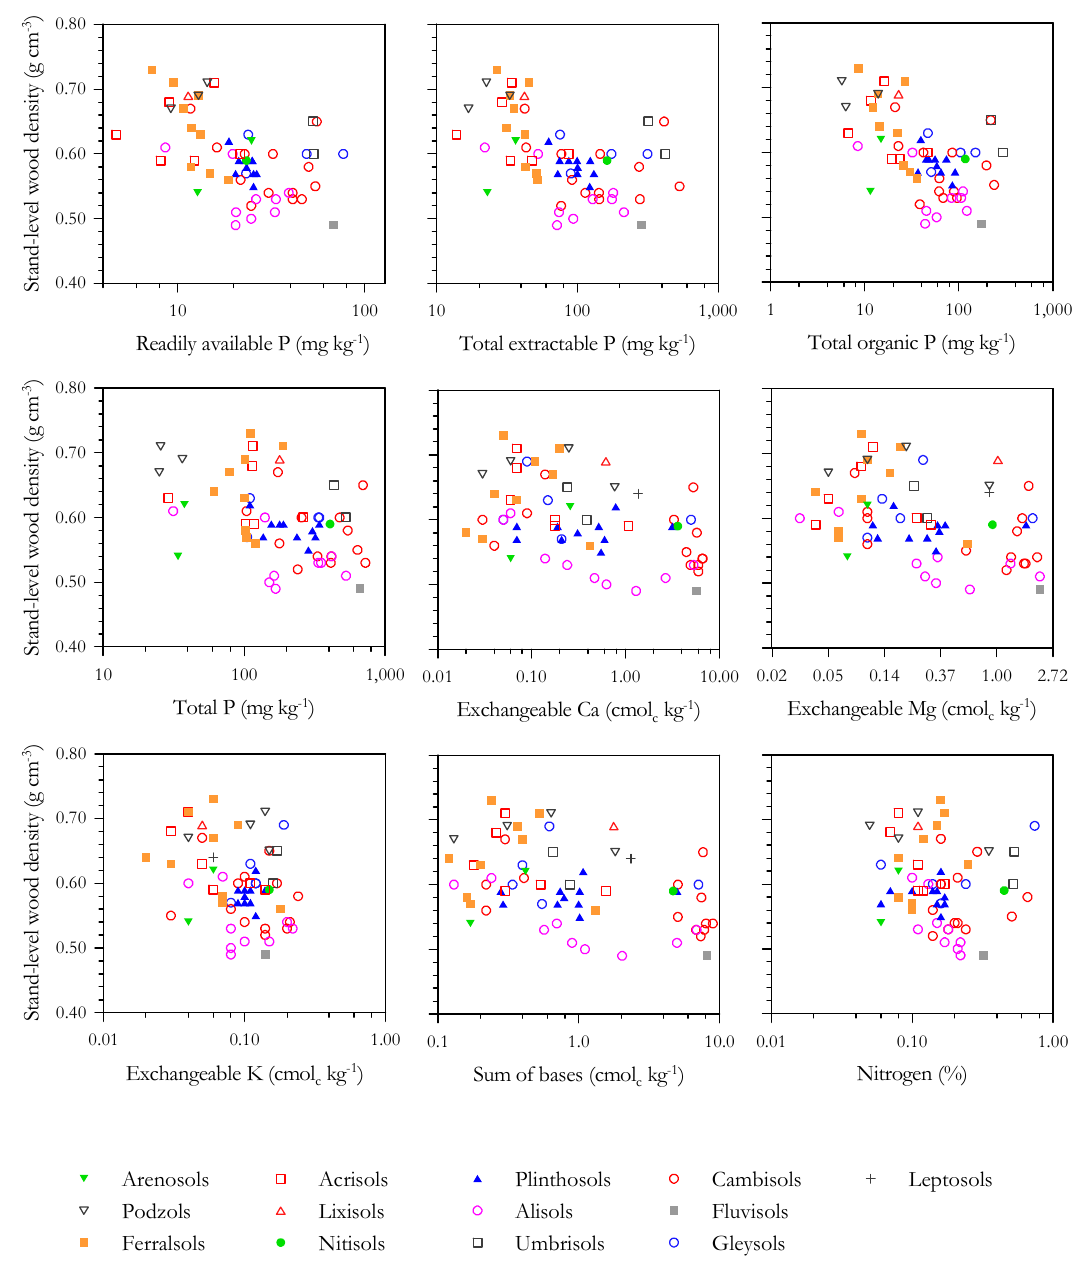
Fig. 6. Relationships between average stand wood density and different soil nutrient measures.